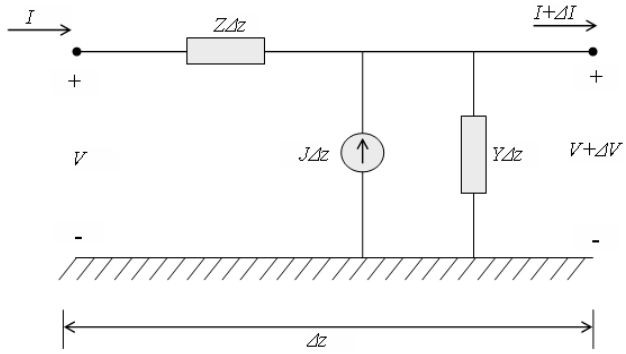
Figure 1. Per unit length equivalent transmission line circuit with corona.